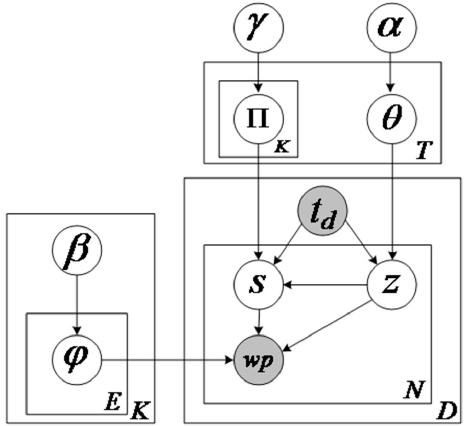
Figure 4. The graphical model of the Topic-Specific Emotion Mining (TSEM) model: unlike existing emotion topic models, emotion relies on topic rather than the opposite, and observable data ‘timestamps’ are added in our model. Table 1. Description of notation used in this paper.